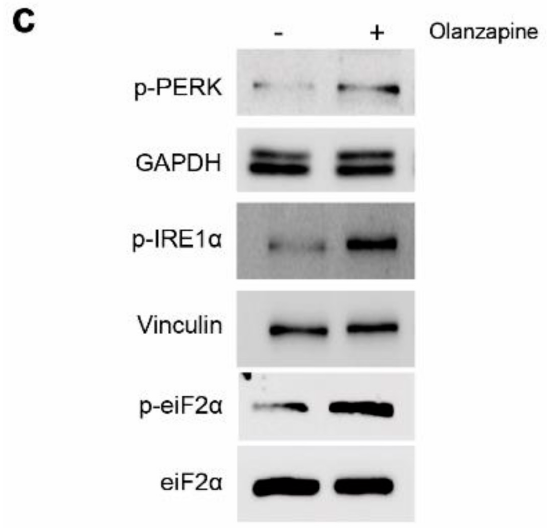
Figure 2. Effects of olanzapine treatment on ER-stress-mediated signaling in INS-1 beta cells and pancreatic islets. ( a ) Western blot analysis of the effect of olanzapine in ER stress markers in INS-1 beta cells after 4 h of treatment showing phosphorylation levels of PERK, eIF2 α and IRE1 α . Control: 0.01% DMSO was used as a vehicle. Representative Western blot images are shown. P-PERK, p-IRE1 α and tubulin correspond to the same gel, and p-eiF2 α and eiF2 α correspond to the same gel. The graphs show the fold increases versus control cells. Tubulin and total eIF2 α were used as loading controls. The experiments were repeated six times, independently, with INS-1 cells in different passages, with triplicate conditions in each one. Data are presented as mean ± SEM of n = 6 independent experiments (3 replicates/condition), passage 25–35. p -values were determined by one-way ANOVA and Bonferroni Post-hoc test. * p < 0.05, *** p < 0.001 versus control (non- treated) cells. ( b ) XBP1 splicing analyzed in INS-1 beta cells treated with olanzapine under similar experimental conditions. Data are presented as mean ± SEM of n = 2 independent experiments (3 replicates/condition). Differences between 2 groups were compared using the Mann–Whitney U test ** p < 0.01 versus control (non-treated) cells. ( c ) Pancreatic islets from female mice were incubated with 6 µ M olanzapine for 4 h, and phosphorylation levels of PERK, IRE1 α and eIF2 α were analyzed by Western blot. Representative Western blot images from 2 independent experiments are shown. P-PERK and GAPDH correspond to the same gel, p-IRE1 α and Vinculin correspond to the same gel and p-eiF2 α and eiF2 α correspond to the same gel. Each lane corresponds to a cell lysate from a pool of 80–100 islets isolated from one mouse. Similar results were obtained in pools of islets from 2 independent